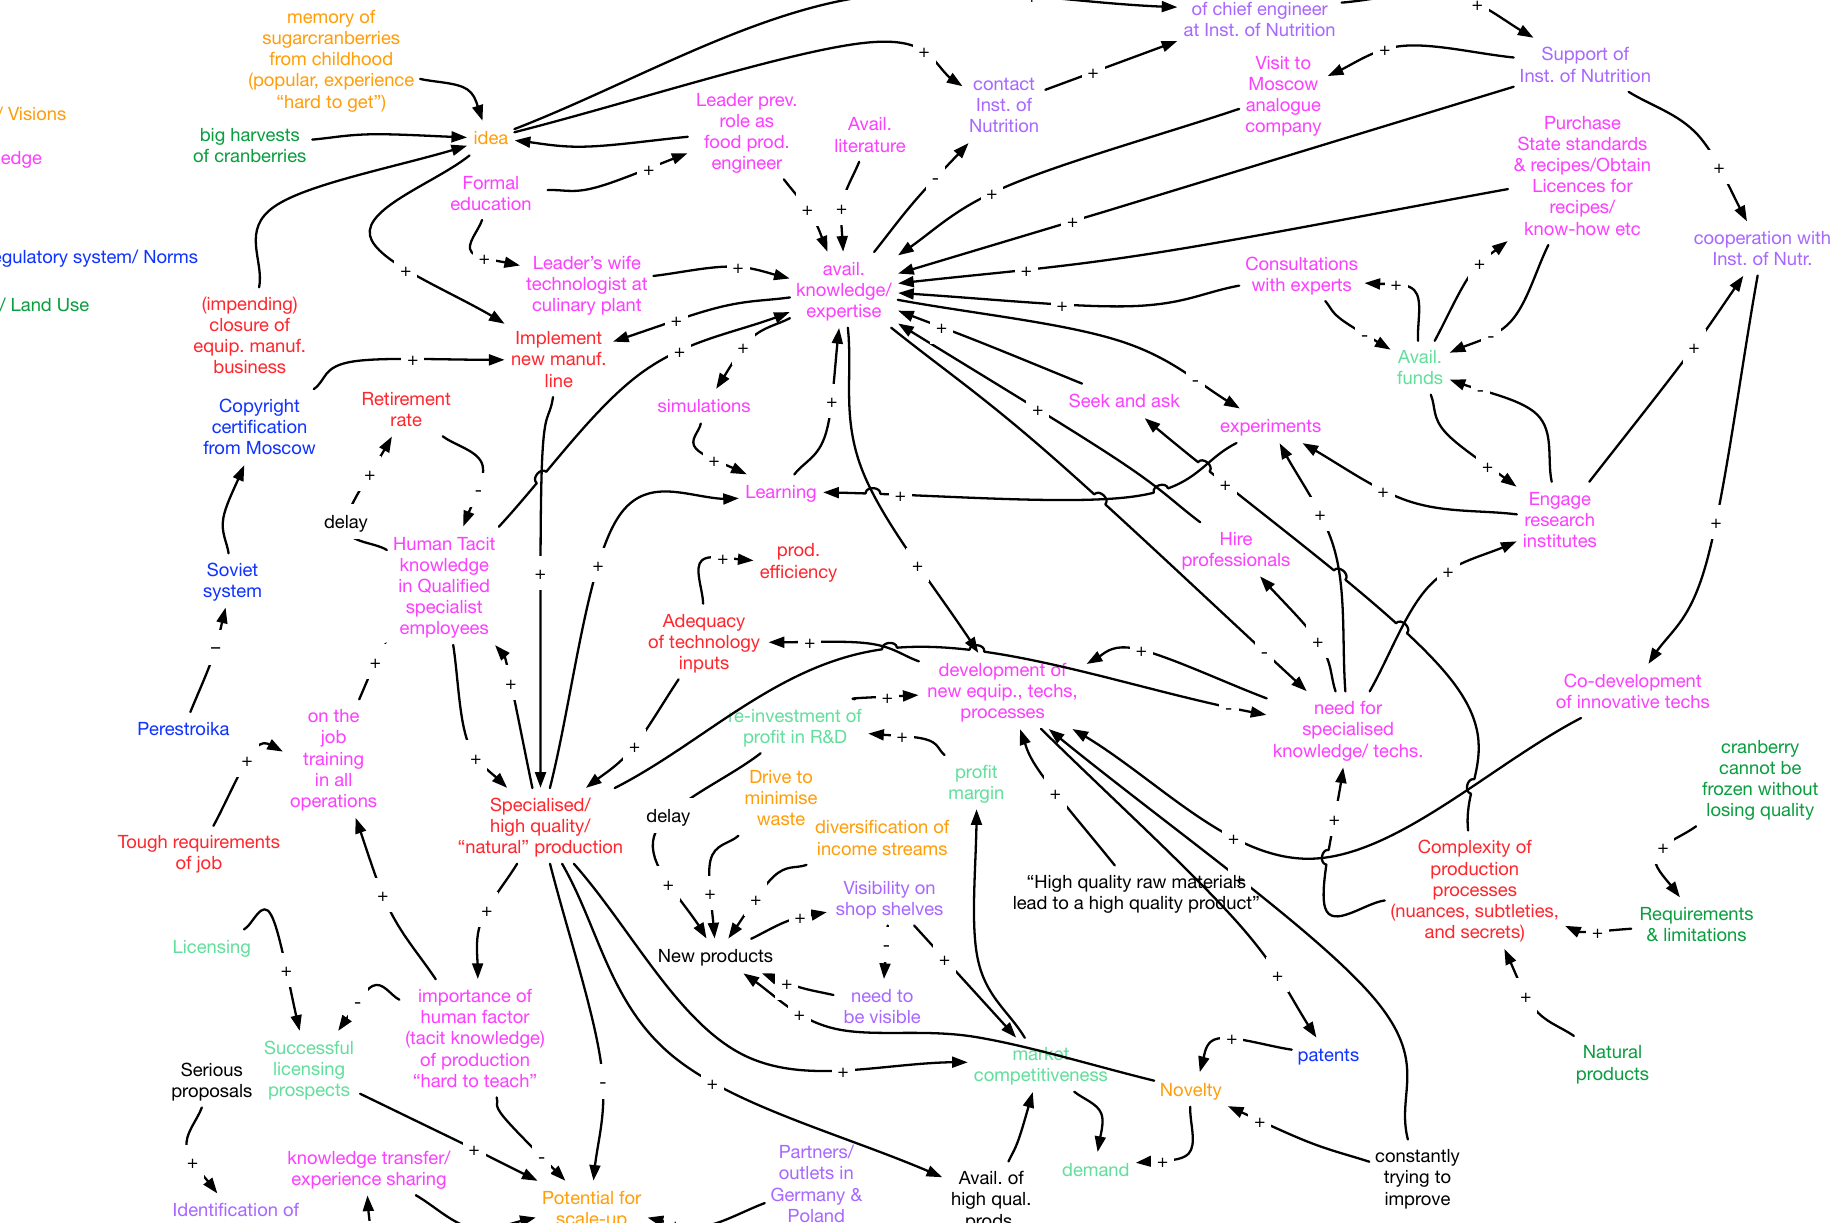
Figure A2:15. Case Berries, Theme: Learning,